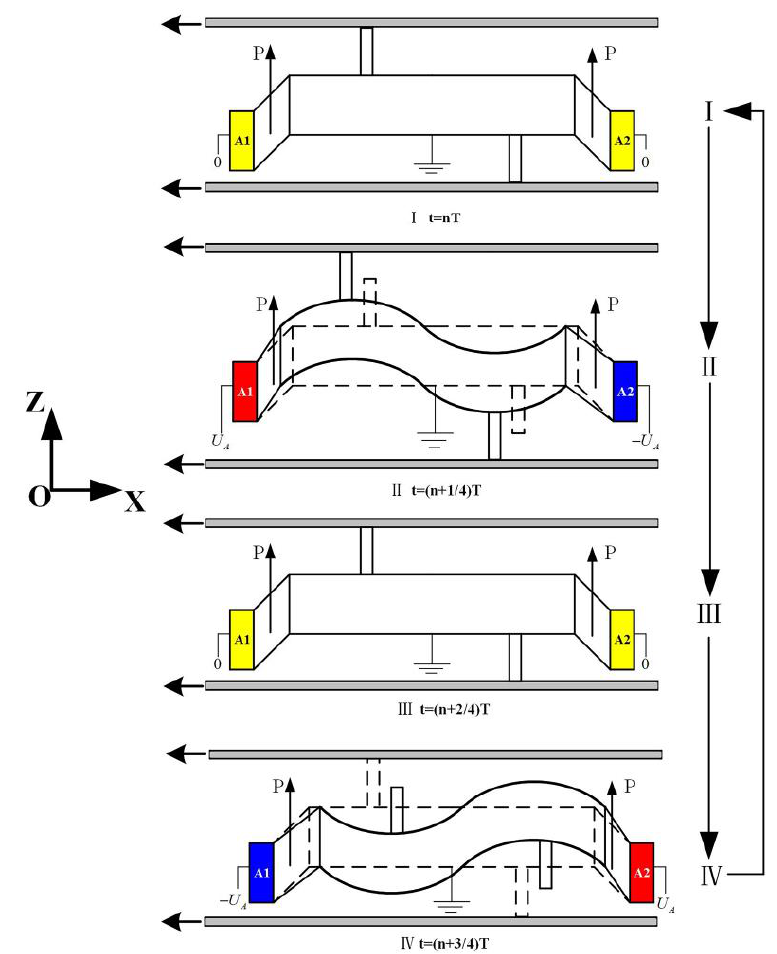
Figure 3. Operating principle of the motor. (P and the arrow next to it mean the direction of polarization of the ceramic.)